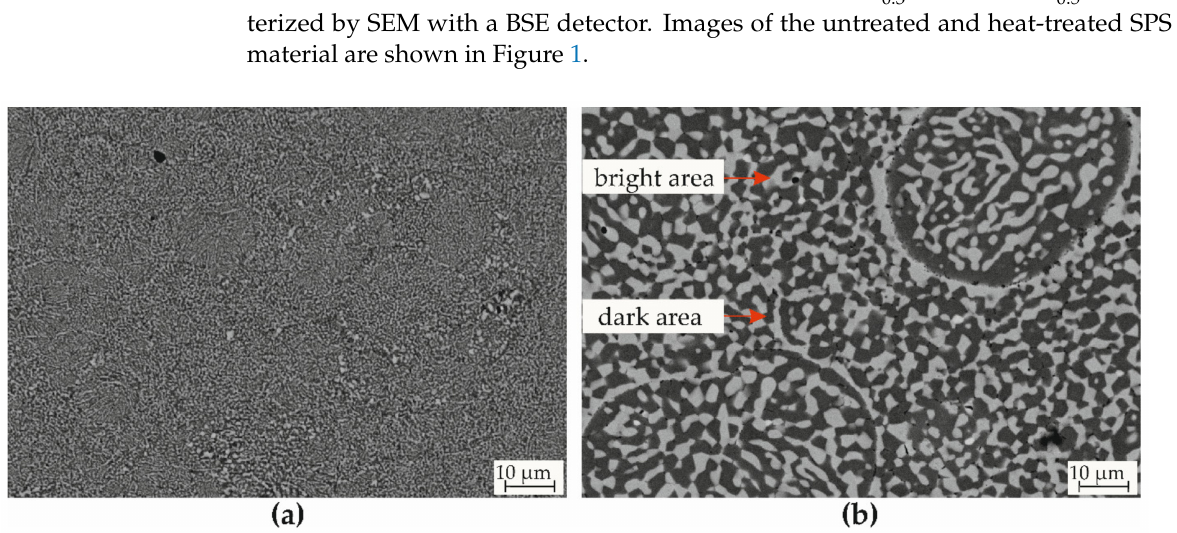
Figure 1. Microstructures (SEM, BSD) of the Al 0.3 CoCrFeNiNb 0.5 SPS bulk material: ( a ) untreated and ( b ) heat-treated. The contrast in the BSD images suggests the presence of at least two different phases. The untreated SPS bulk material exhibits a fine lamellar structure. Due to the heat treatment, the microstructure